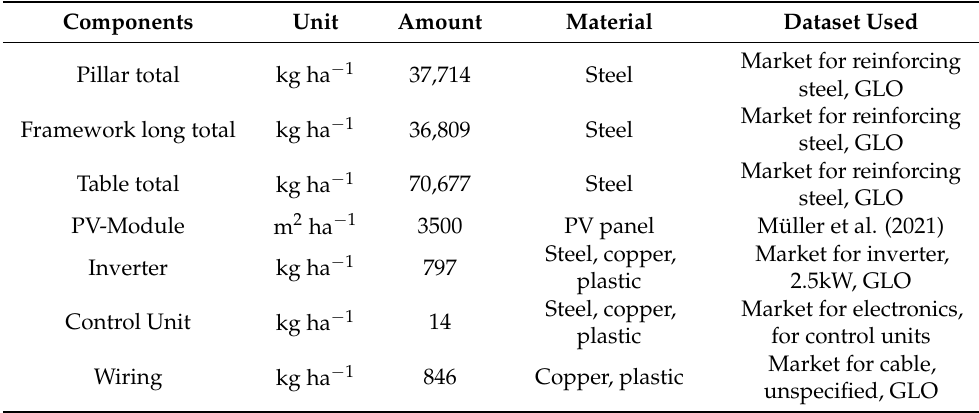
Table 3. Inventory of the components and materials used in the